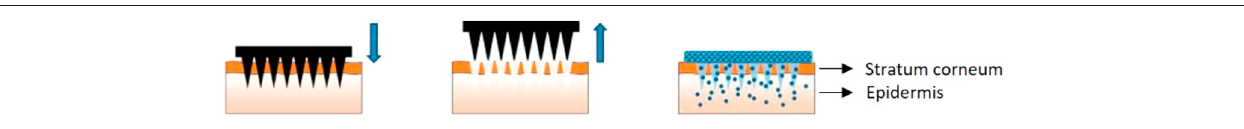
FIGURE 2 | A schematic representation of solid MNs pretreatment for increasing the permeability of nanoparticles by creating micro-holes across the skin (Eneko et al.,